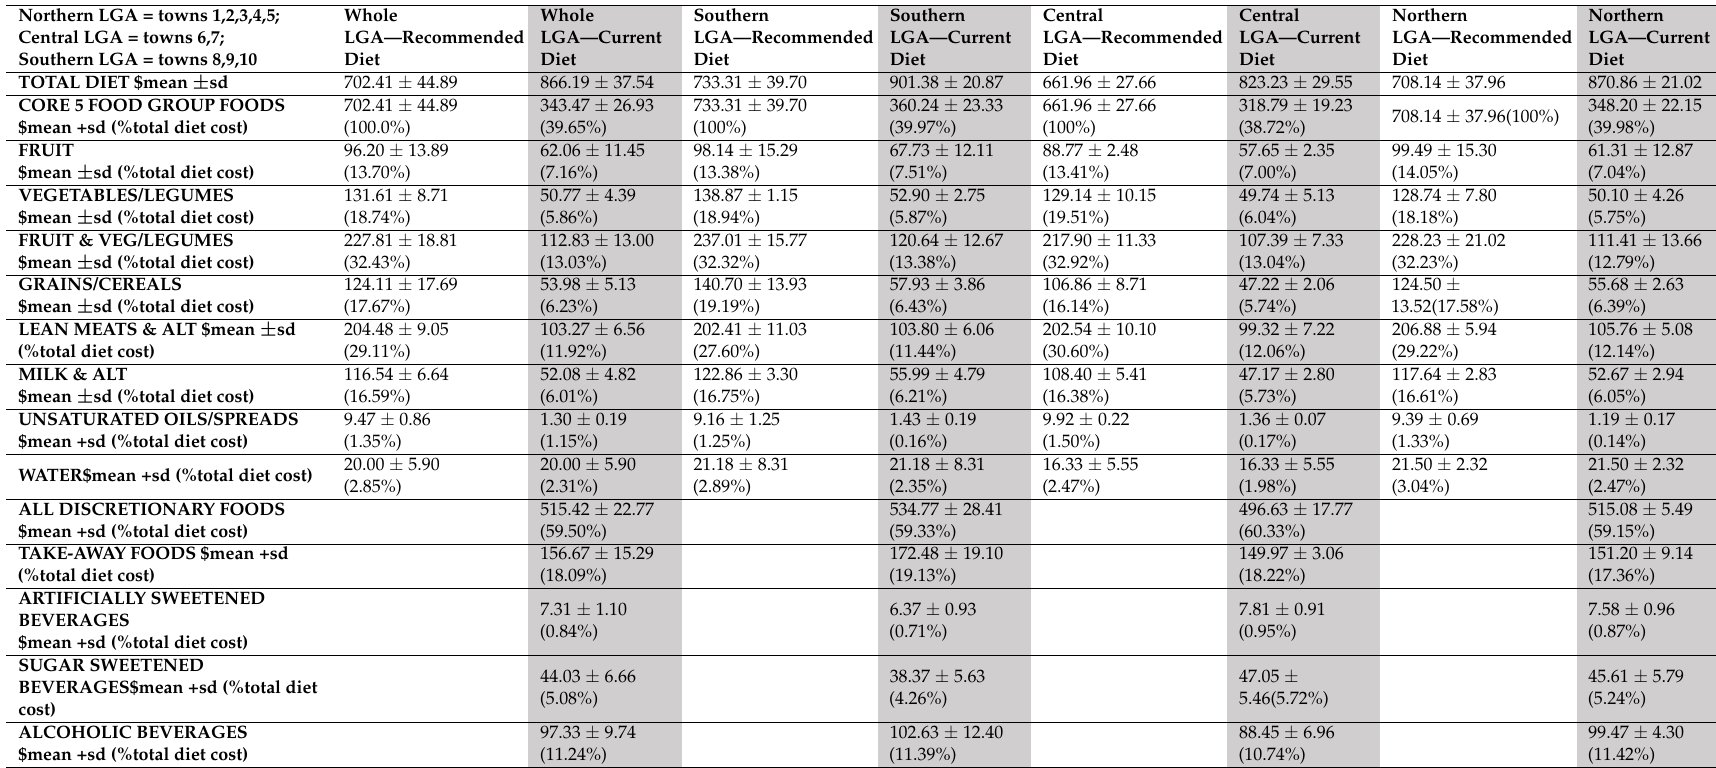
Table A1. Price of recommended and current diets for the Local Government Area (using a reference household of two parents and two children). Northern LGA = towns 1,2,3,4,5; Central LGA = towns